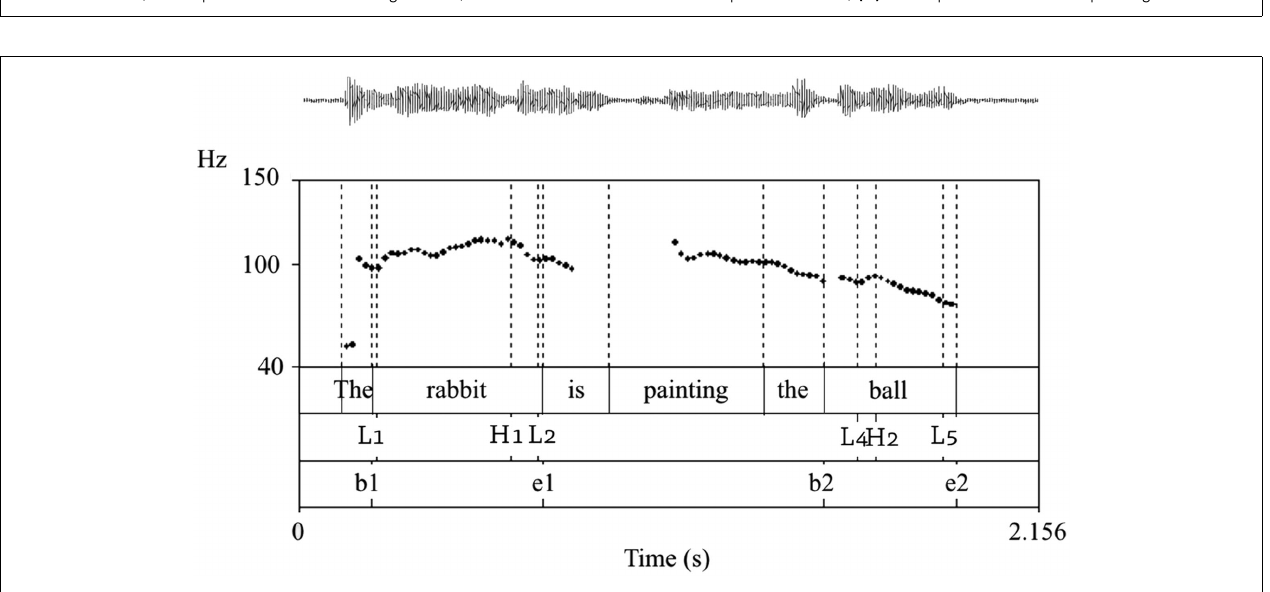
object noun “ball” are the following: F0 minimum in the rising portion (L1/L4), F0 maximum (H1/H2), F0 minimum in the falling portion (L2/L5), beginning of the word (b1/b2), and end of the word